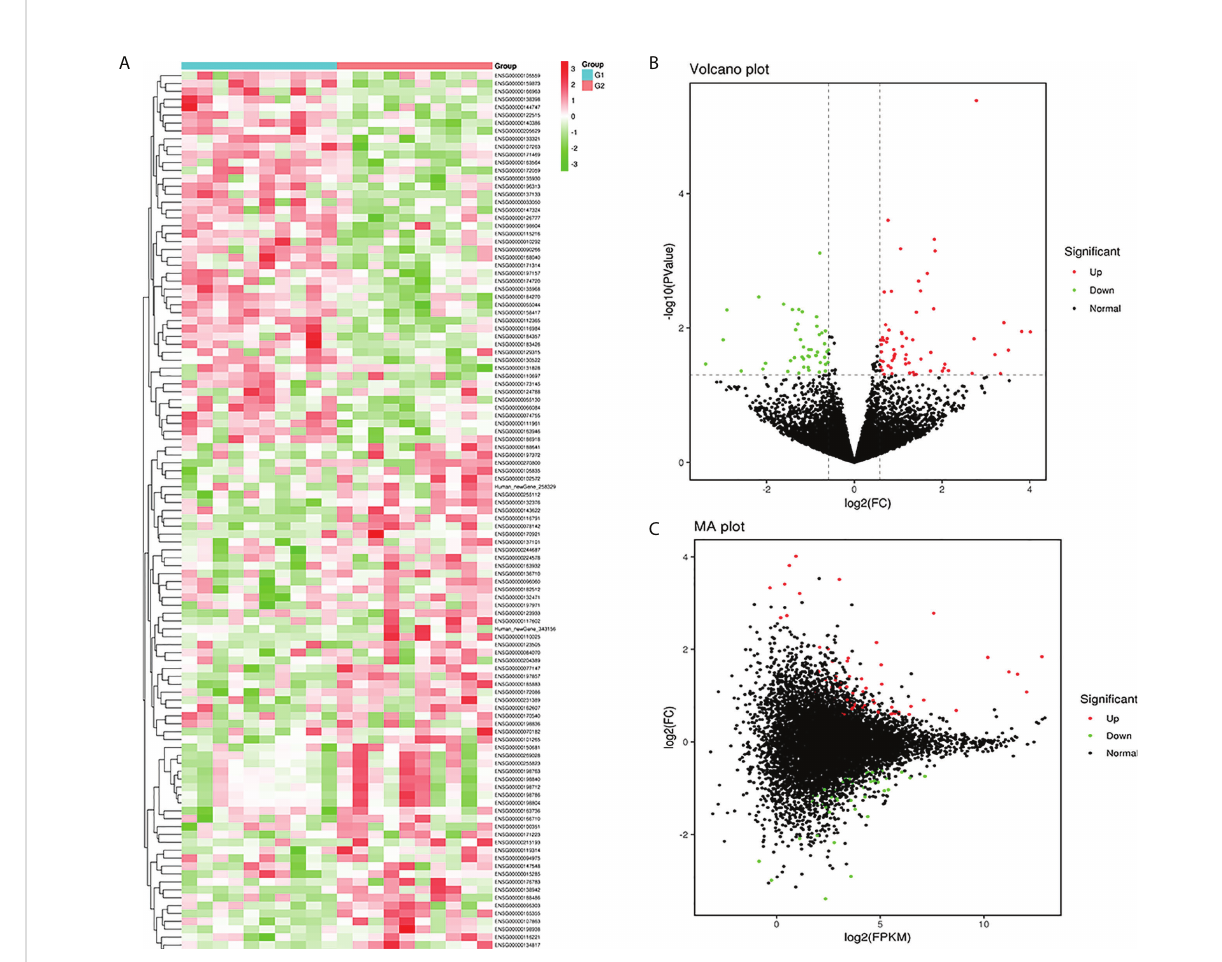
FIGURE 3 Exosomal mRNA pro fi les of type 1 diabetes mellitus (T1DM). Heatmap (A) of the expression levels of the identi fi ed differentially expressed mRNAs (DEMs). Red and green represent high and low expression, respectively. G1: control group (N=10); G2: case group (N=10). A volcano diagram (B) and M-versus-A (C) plot were used to show DEMs in T1DM. The Mann − Whitney U test was used to identify DEMs with cutoffs of FPKM > 5, P value < 0.05 and |log2(FC)| > 0.584. Upregulated DEMs (red dots); downregulated DEMs (green dots); nondifferentially expressed mRNAs (black